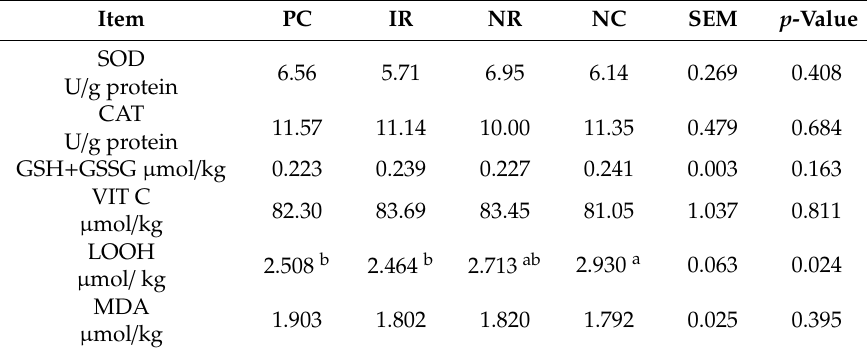
Table 8. Indicators of redox status in the breast muscle of turkeys.